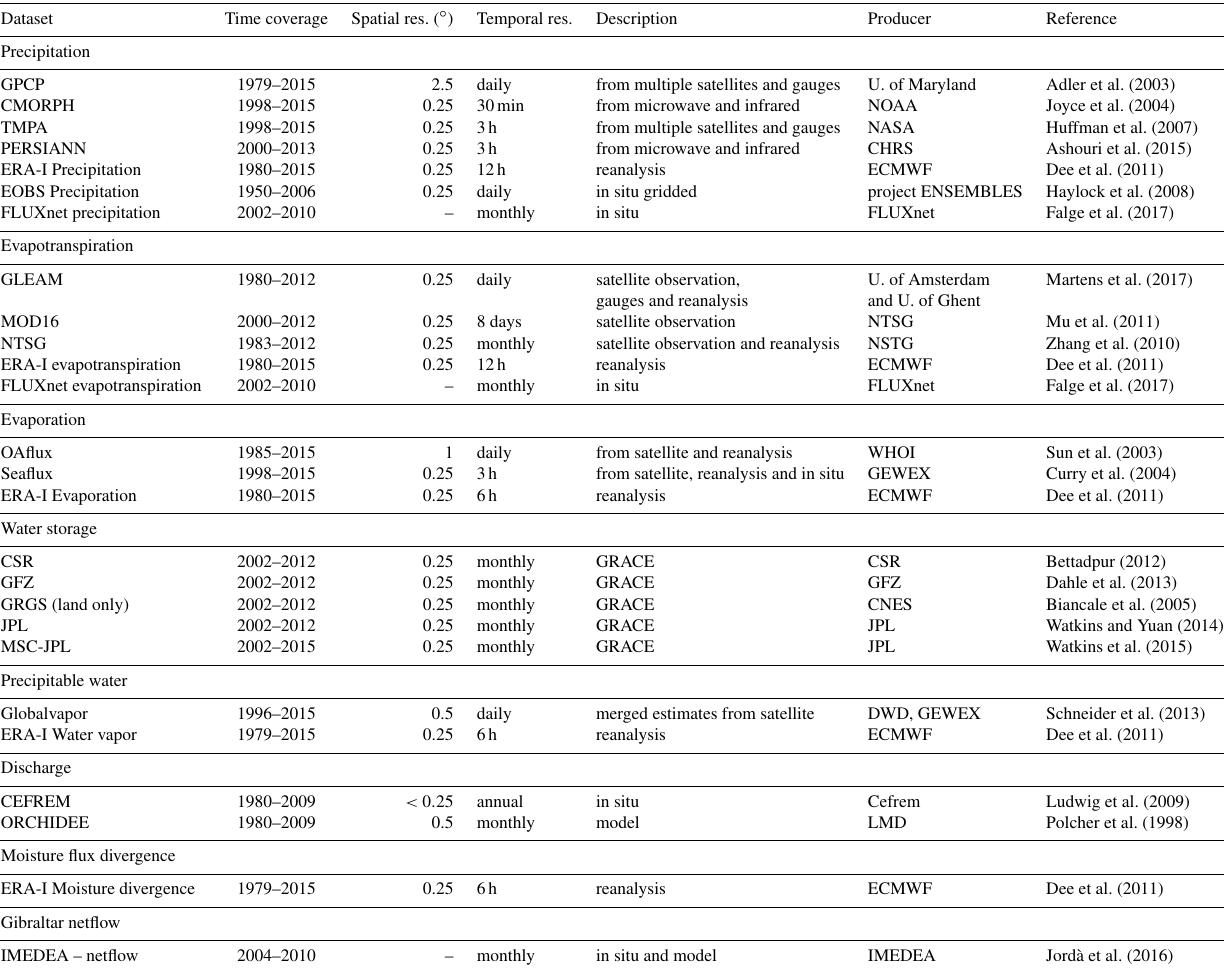
Table A2. Overview of the various datasets used in this study. Their common coverage period, on which the WC budget is estimated, is